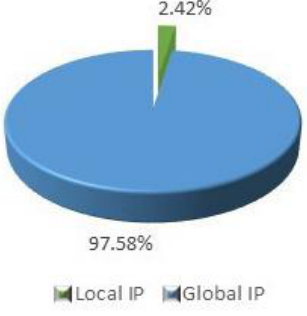
Figure 2. Distribution of IP addresses